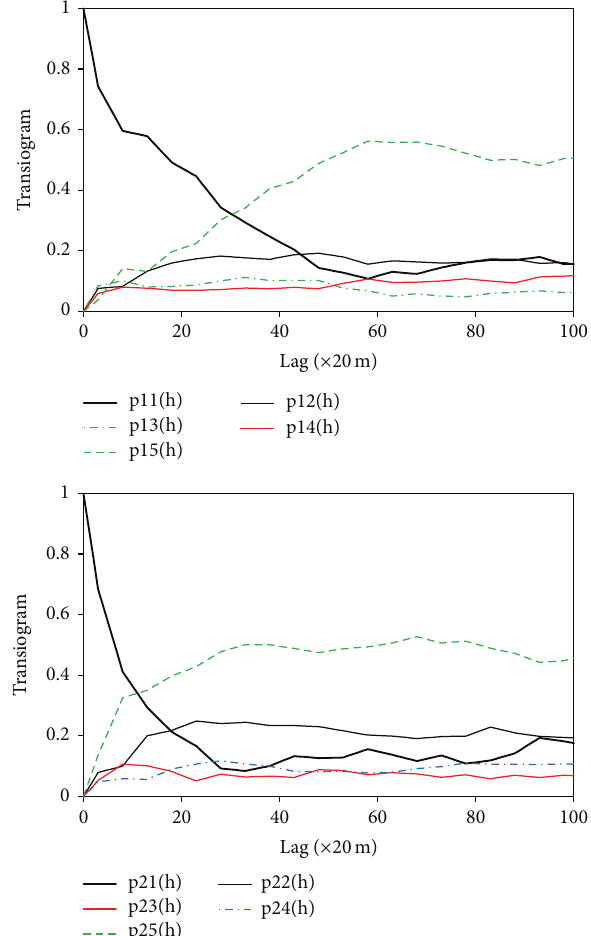
Figure 4: Two subsets of transiogram models interpolated from experimental transiograms estimated from the sample data. The numbers in transiogram labels (1 to 5) refer to the five updated soil series (i.e., SU2, SU3, SU4, SU6, and SU7),